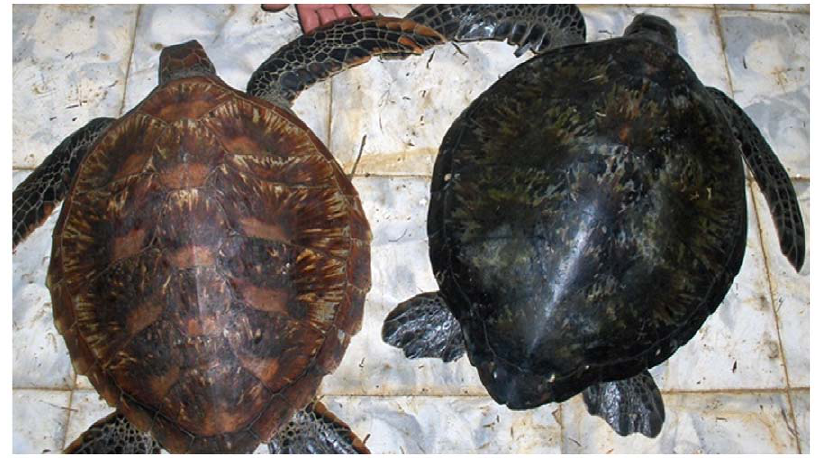
Figure 2. Observed variations in carapace color and shape of green turtle ( Cheloniamydas ) juveniles. Variations corresponding to the Australasian (CMP21, CMP 22 and CMP 97) and central/eastern Pacific (CMP4, CMP 8, CMP 5, CMP 17) haplotypes (left and right turtles, respectively) caught at the Gorgona foraging study site. Putative west Pacific turtles exhibited a much lighter golden-brown coloration with indentation in the lower carapace edges, in contrast to the darker ‘‘black’’ carapaces of the typical eastern Pacific individuals. Photo: Javier Rodrı´guez-Zuluaga.